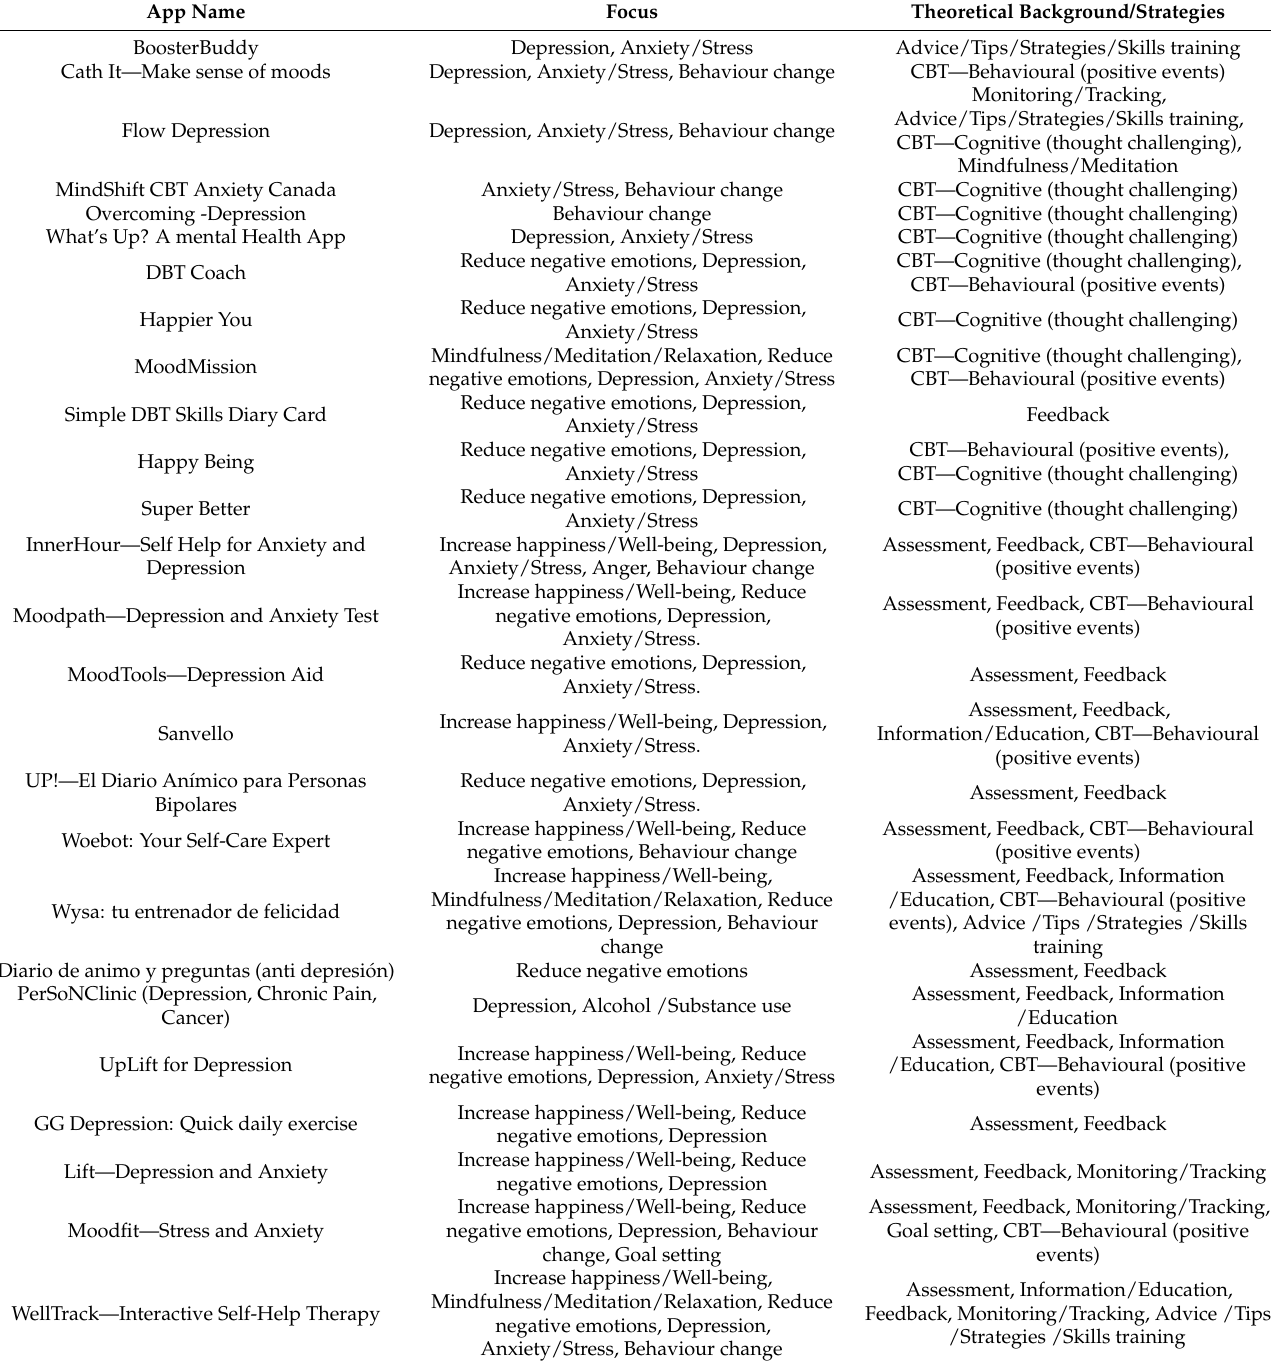
Table 2. Theoretical background/strategies and focus of the app (according to the MARS